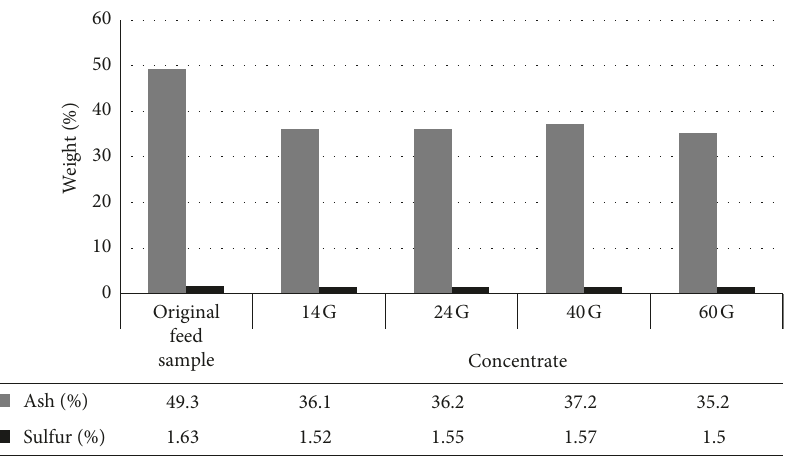
Figure 10: Sample-C2 Knelson gravity ash % and sulfur % analysis chart (